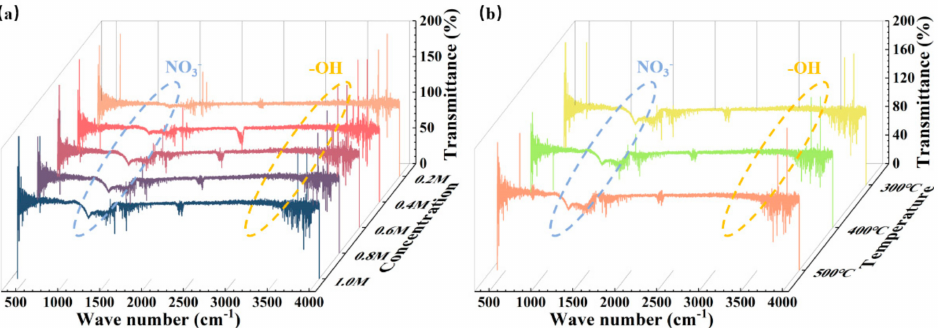
Figure 7. ZYAMO thin film FTIR results: ( a ) 300 ◦ C annealing temperatures and ( b ) 0.25 M solution